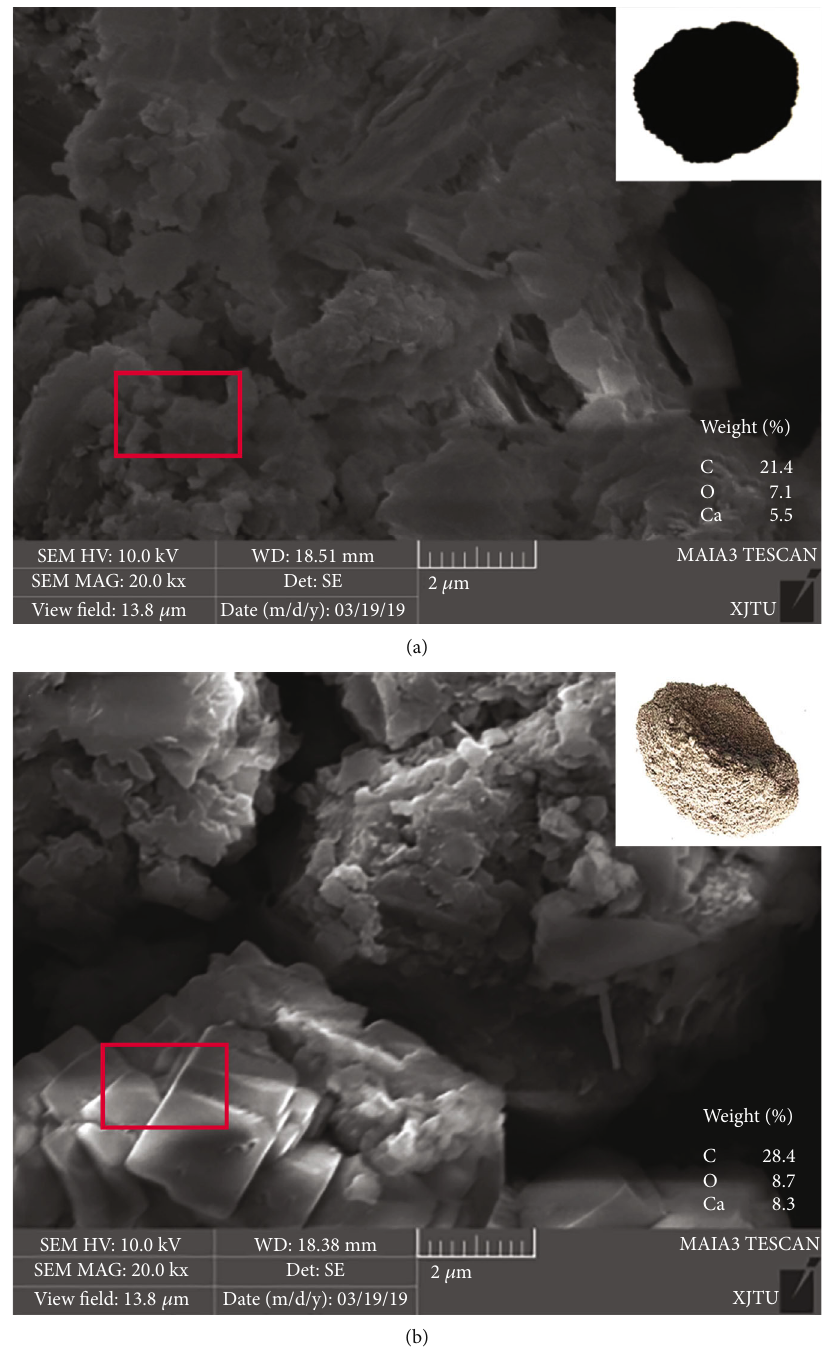
Figure 1: (a) SEM image of HA: insert is the outlook of HA; (b) SEM image of AHA: insert is the outlook of